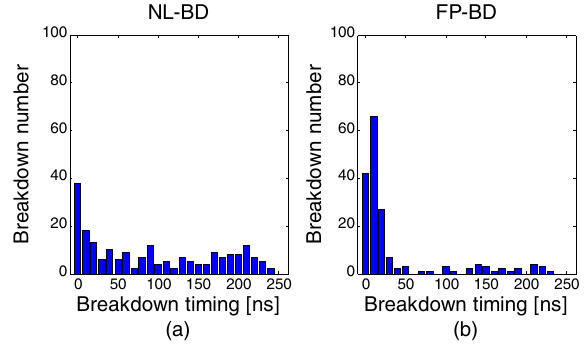
FIG. 17. Breakdown timing distribution of T24_#3.